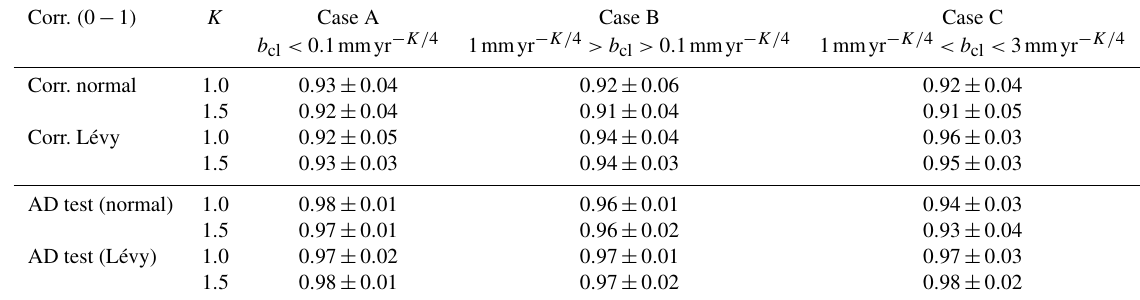
Table 3. Correlation between the distribution of the residuals and the normal (corr. normal) distribution or the Lévy α –stable distribution (corr. Lévy) and the Anderson–Darling test (AD) following scenarios A, B, and C. The result of the AD test is the probability over the 50 trials of not rejecting the null hypothesis. Lévy or normal means the type of distribution used as the null hypothesis. Corr. ( 0 − 1 ) K Case A Case B Case C b cl < 0 . 1mmyr − K/ 4 1mmyr − K/ 4 > b cl > 0 . 1mmyr − K/